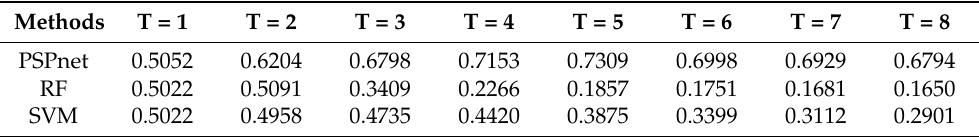
Table A12. The IoU of sample size S = 90 varies with the threshold level T.